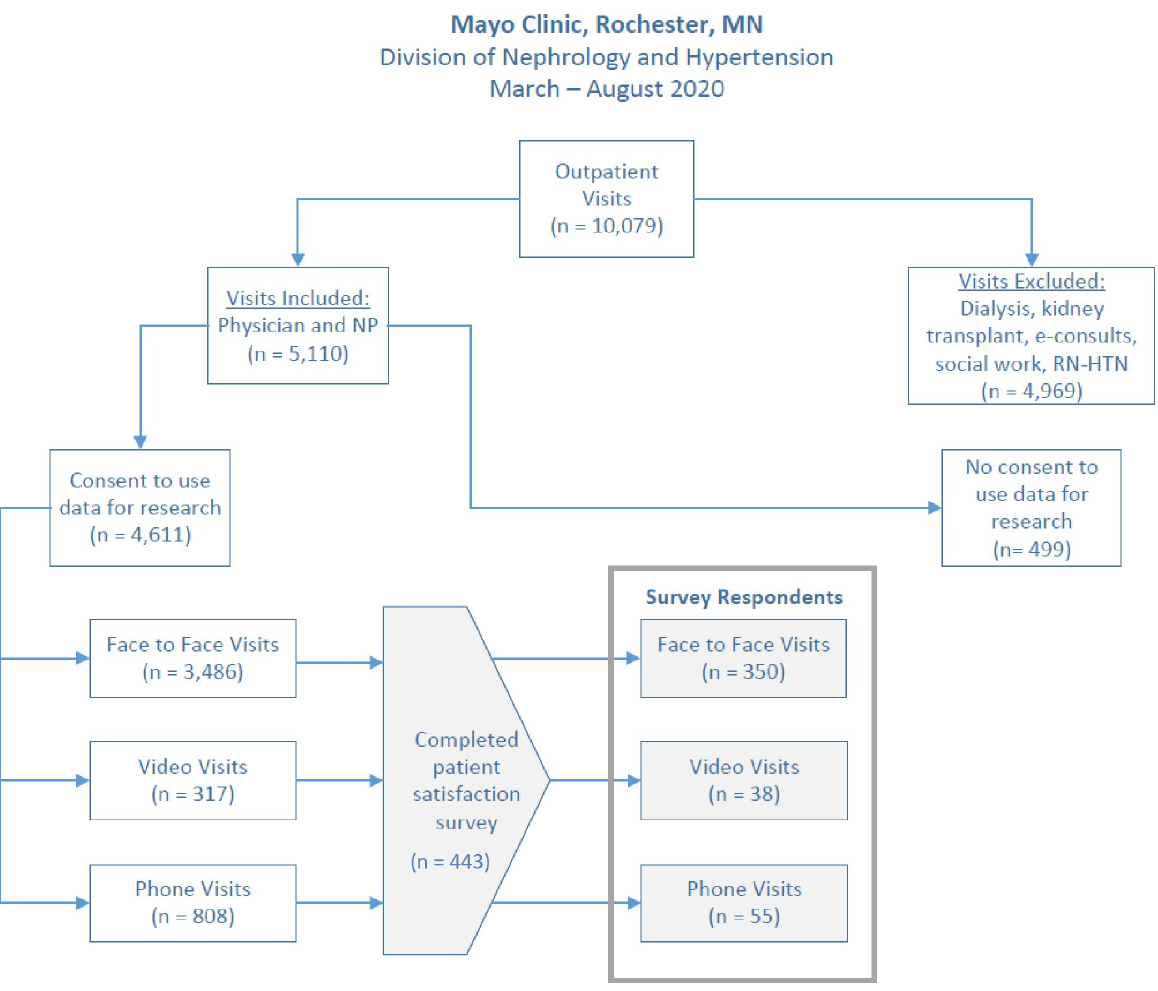
Fig 1. Patient encounter selection criteria. This schematic outlines the patient selection